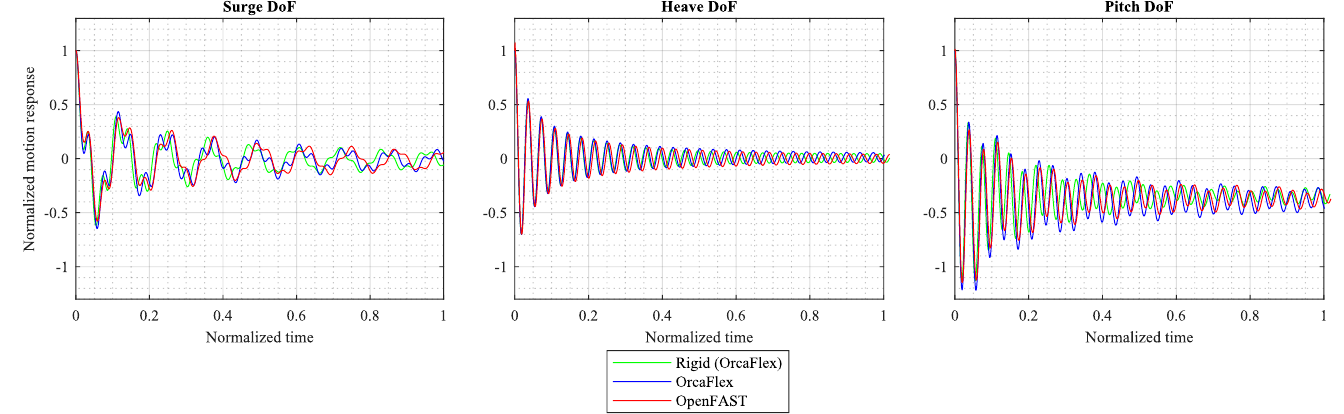
Figure 4. Comparison of free decay tests. ( Left ) Surge, ( Middle ) Heave, ( Right )